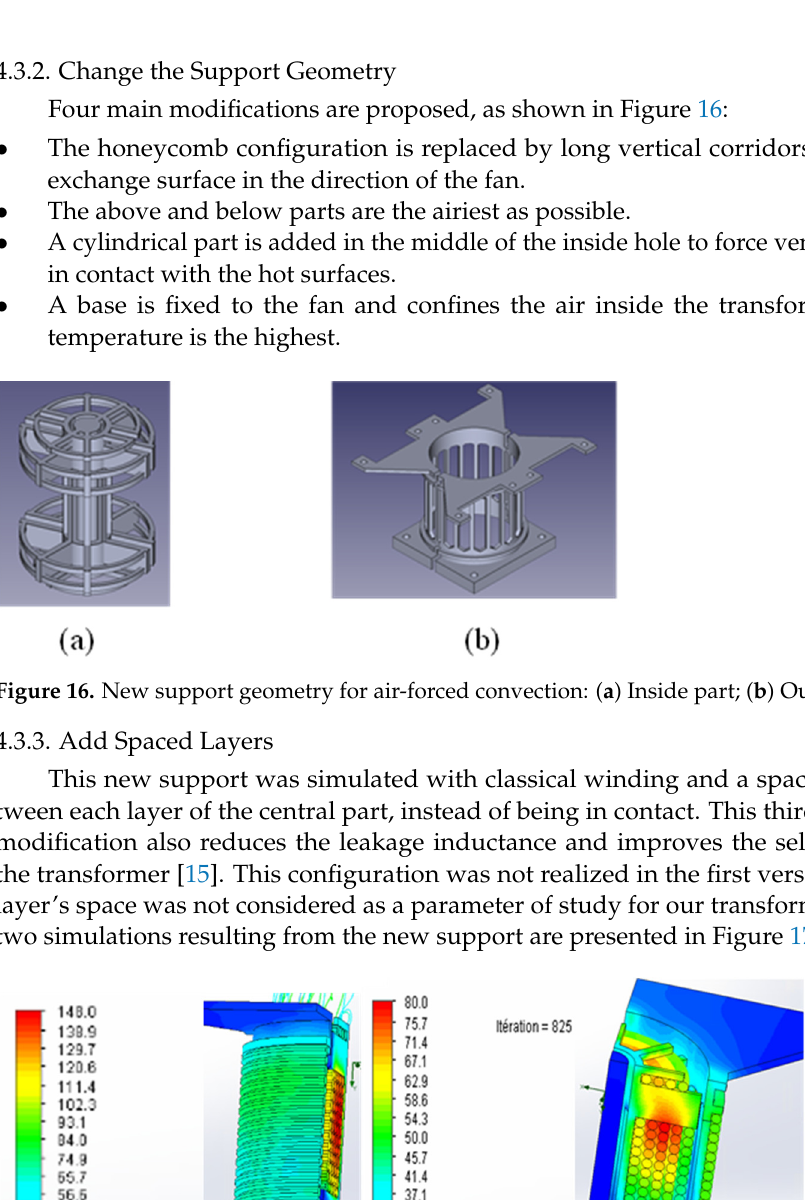
Figure 18. Air-core transformer: Left: Natural convection; Right: Air-forced convection.